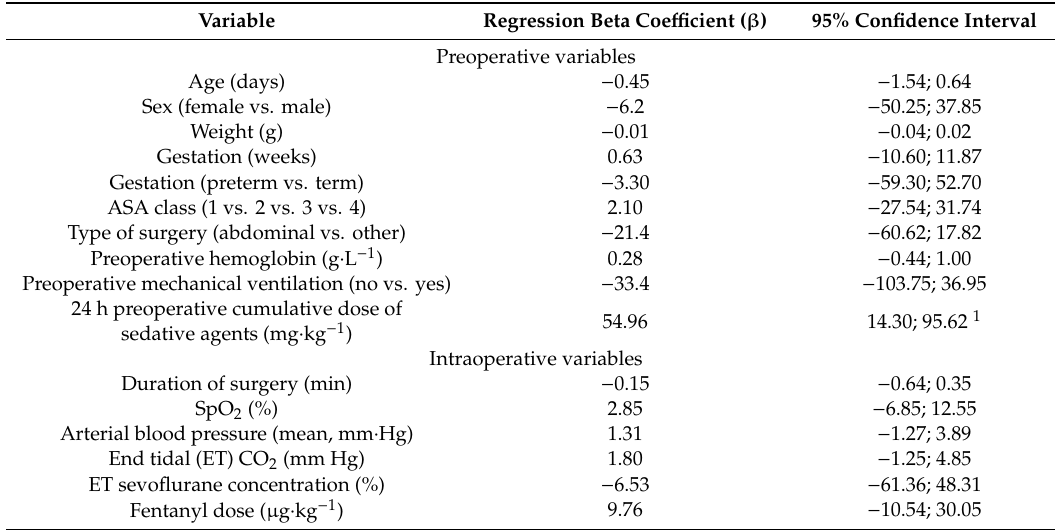
Table 3. Univariate 0.75 quantile regression model for the % of time of intraoperative hyperoxia FTOE including the demographic and clinical data and the cumulative doses of preoperative sedative agents as potential predictors.